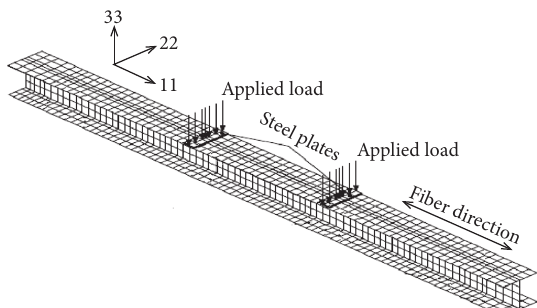
Figure 12: Finite element geometry and mesh (Yosri et al. [10]).